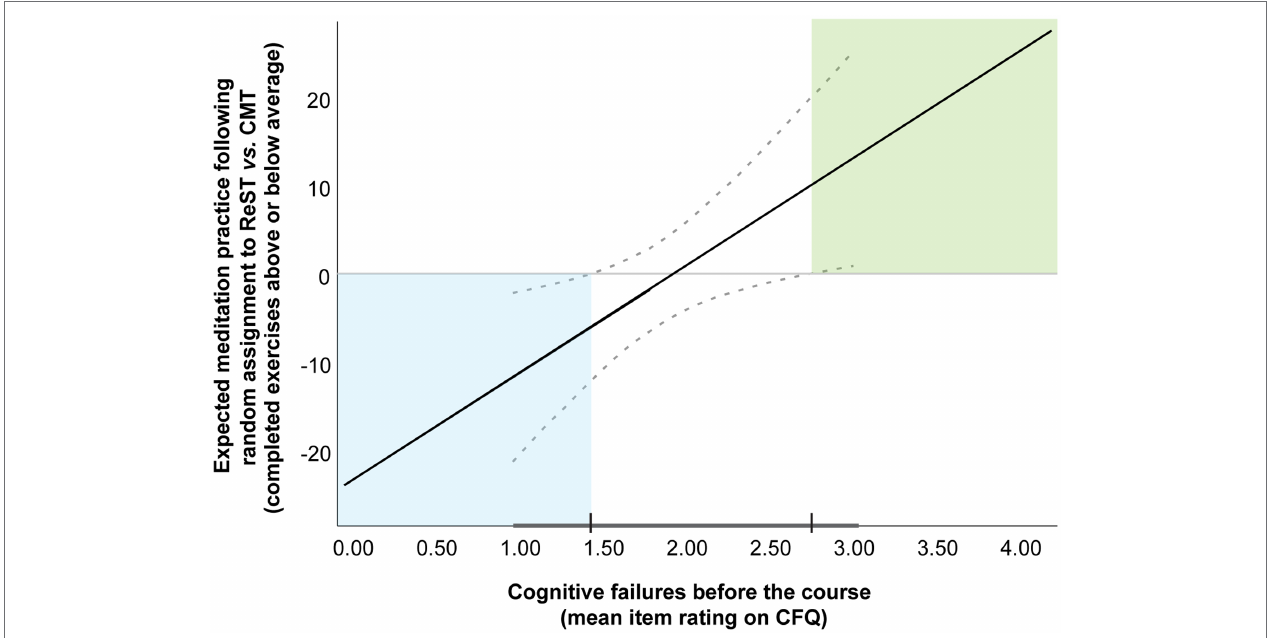
FIGURE 2 | Johnoson–Neyman plot showing the observed moderation of the relationship between self-ratings of cognitive functioning before the course (average item response on the Cognitive Failures Questionnaire) and subsequent meditation practice (number of completed formal and informal mindfulness exercises above or below the sample average) by course type. Higher meditation scores indicate that participants with a given level of initial cognitive functioning completed more homework practice if they had been randomly assigned to restoration skills training (ReST) vs. a formally matched conventional mindfulness training (CMT) course. The dotted lines show the 95% confidence intervals. The thick line along the X-axis shows the range of observed values and the tick marks mark the significance regions: the levels of cognitive functioning above and below which the homework completion rates differed reliably between the